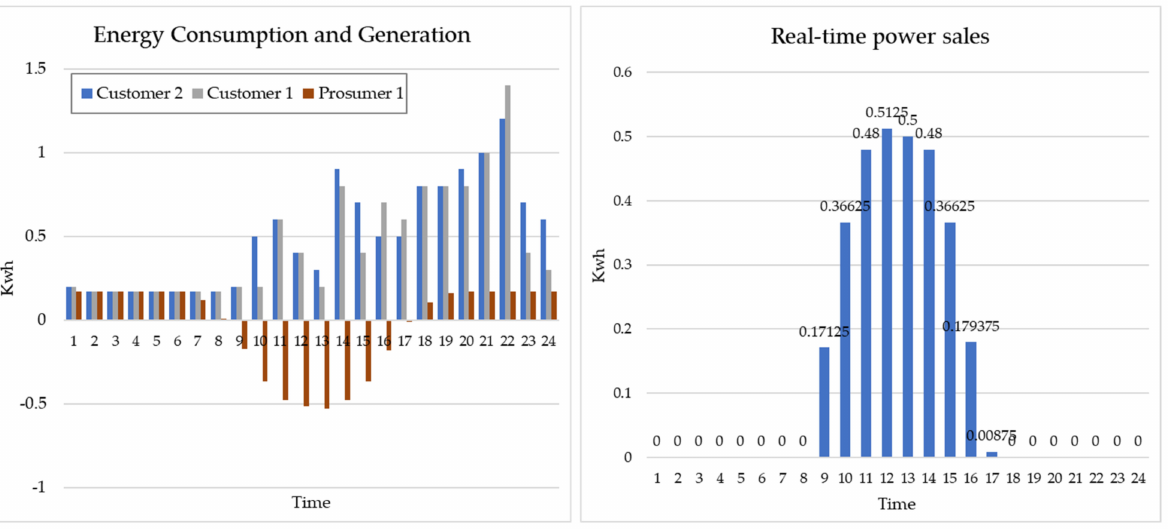
Figure 14. Real-time status of Prosumer 1-Customer 1 and